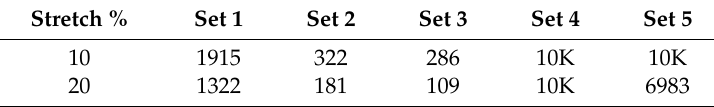
Figure 11. The normalized/absolute resistances of the partially TPU-covered samples at 20% stretching, R 0 : 5.5 Ω . The inset presents the overall trend during all the cycles. Table 3. Number of cycles before the failure (sets 1–5).